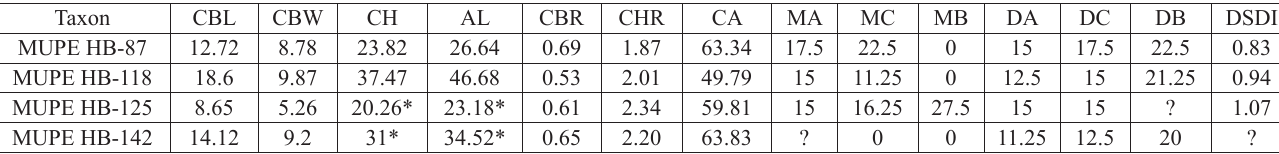
Table 4. Morphometric measurements (in mm) and metric variables from the theropod teeth from Niger. Abbreviations: AL, apical length; CA, crown angle; CBL, crown base length; CBR, crown base ratio; CBW, crown base width; CH, crown height; CHR, crown height ratio; DA, distal denticles in the apical section; DB, distal denticles in the basal section; DC, distal denticles in the central section; DSDI, denticle size difference index; MA, mesial denticles in the apical section; MB, mesial denticles in the basal section; MC, mesial denticles in the central section; * estimated values; ?, values unknown that can not be